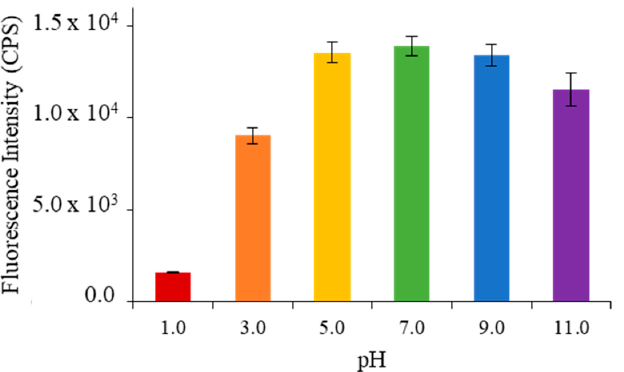
Figure 6. GQDs-hMSNs with changing pH (maleate pH 1.0, citrate 3.0–5.0, HEPES 7.0, CHES 9.0, CAPS 11.0) of the GQDs-hMSNs (36 µg/mL). The same trend was observed for GQDs, where quantum dots quench at pH 1.0 but remain steady in the neutral pHs.